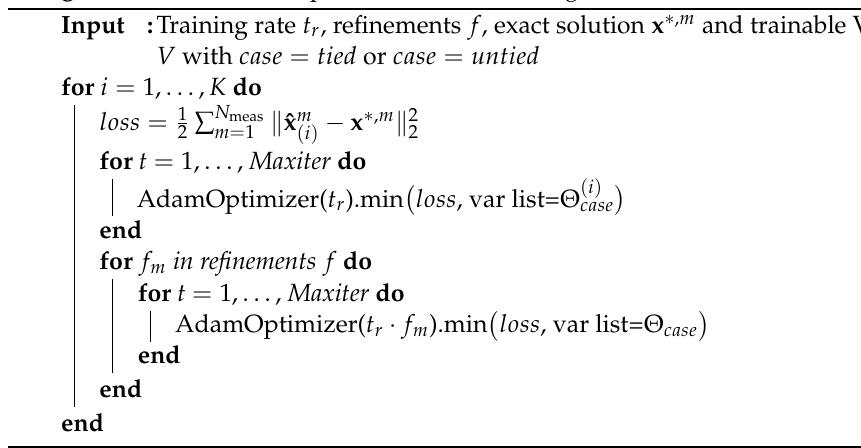
Algorithm 1: LBISTA, implementation of